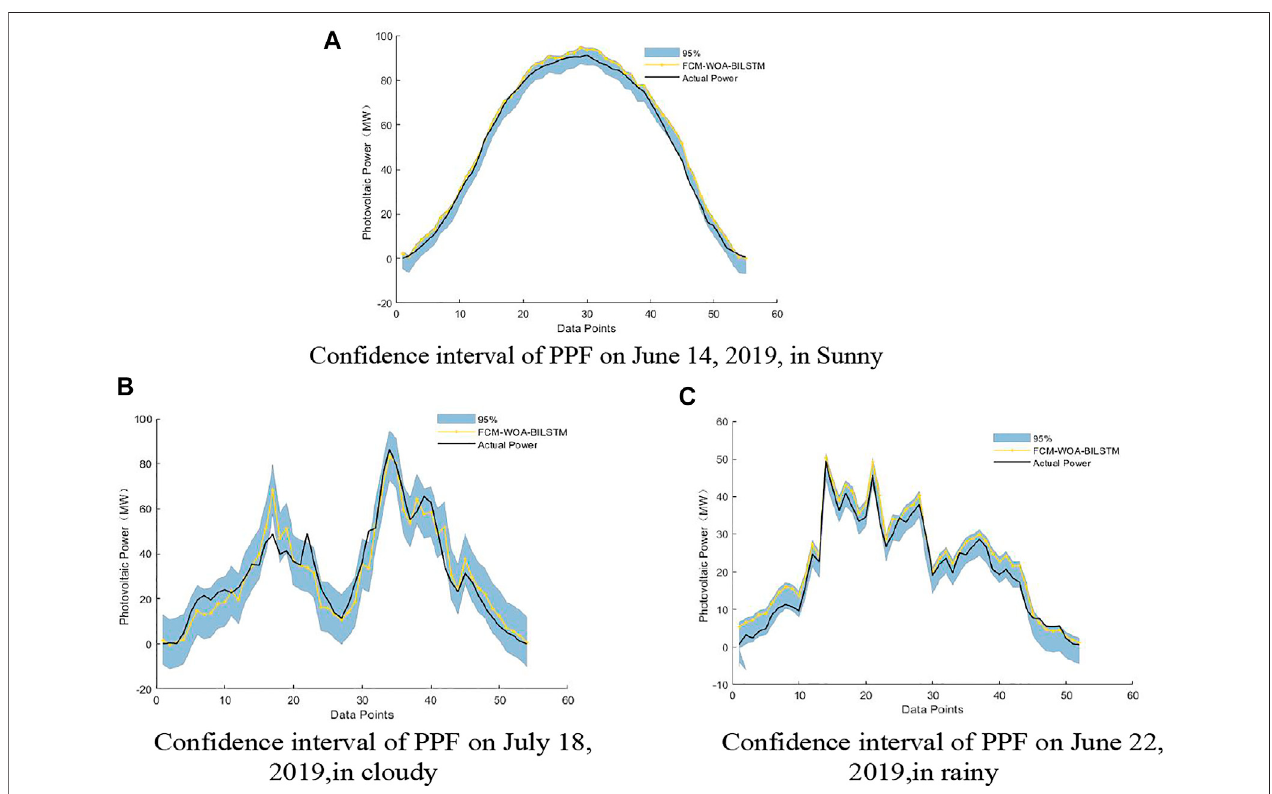
FIGURE 13 | 95% Con fi dence interval of PPF under different climatic